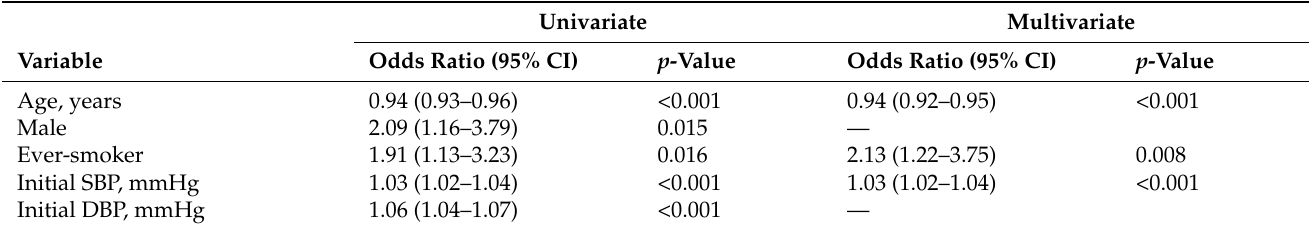
Table 3. Multivariate analysis of factors associated with hemoptysis of unidentified causes.